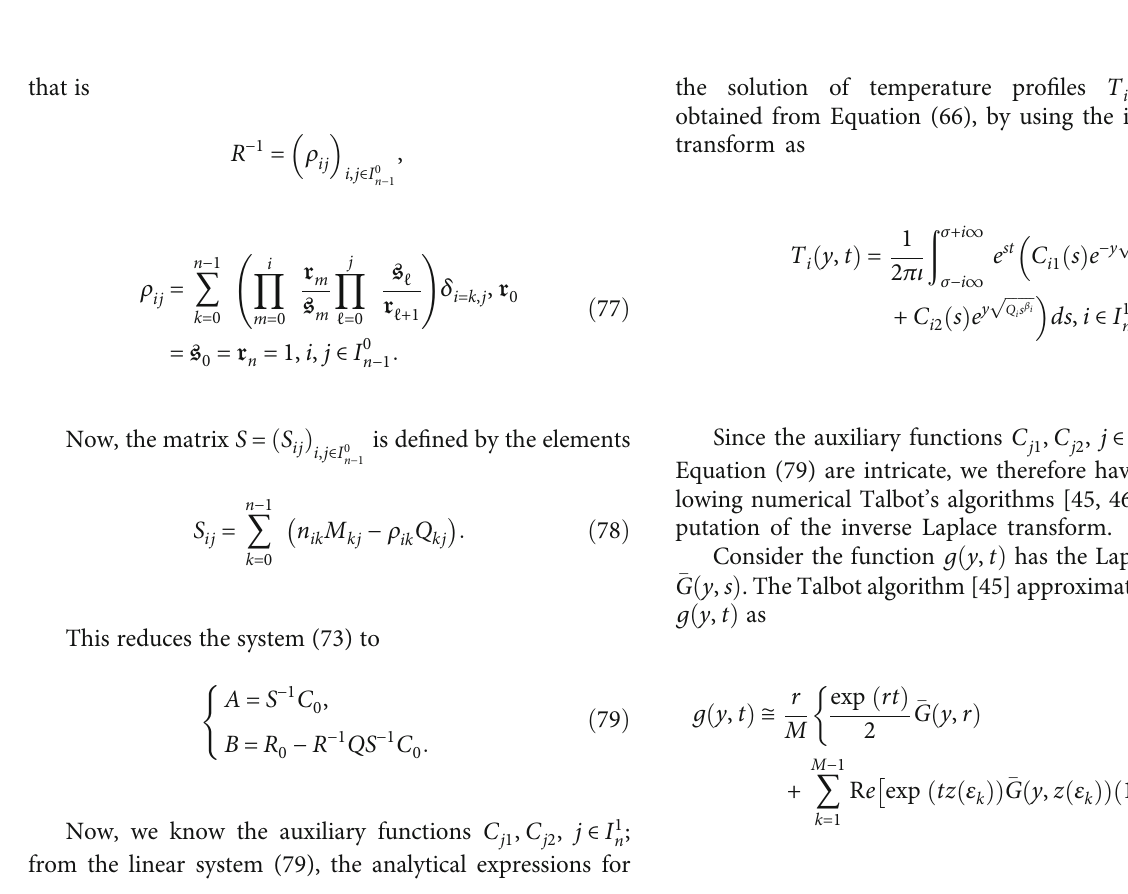
Figure 4: Temperature pro fi les T values of β 3